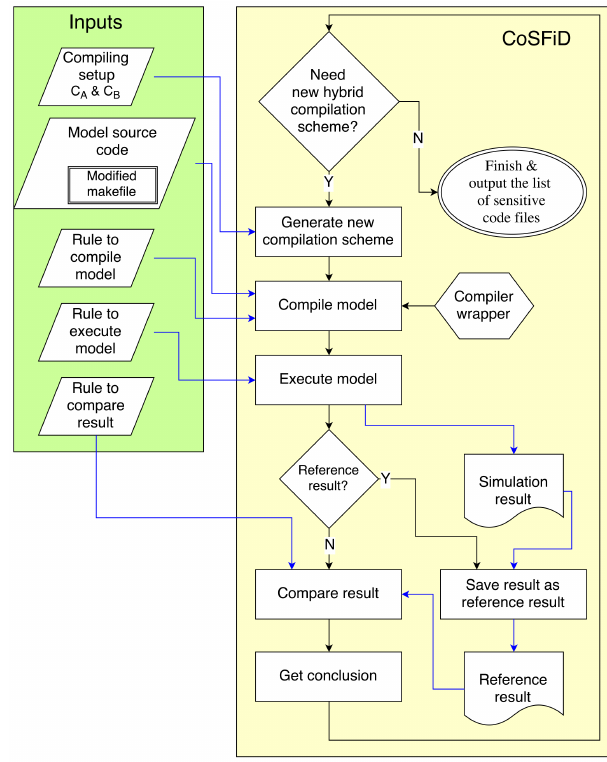
Figure 1. Flowchart of CoSFiD for detecting compilation-sensitive code files. In each iteration, CoSFiD first checks whether it is neces- sary to generate a new hybrid compilation scheme (some code files are compiled with C A and the remaining code files are compiled with C B ) . If unnecessary, which means the whole process of the detection should end, CoSFiD will output all compilation-sensitive code files. Otherwise, CoSFiD generates a new hybrid compilation scheme, and then calls the corresponding rule to compile the model code using the compiler wrapper and run the simulation. If it is the first run of the simulation, which also means all code files are com- piled with C A , the simulation result will be recorded as the ref- erence result. Otherwise, CoSFiD calls the corresponding rule to compare the simulation result to the reference result and then uses the conclusion to drive the next